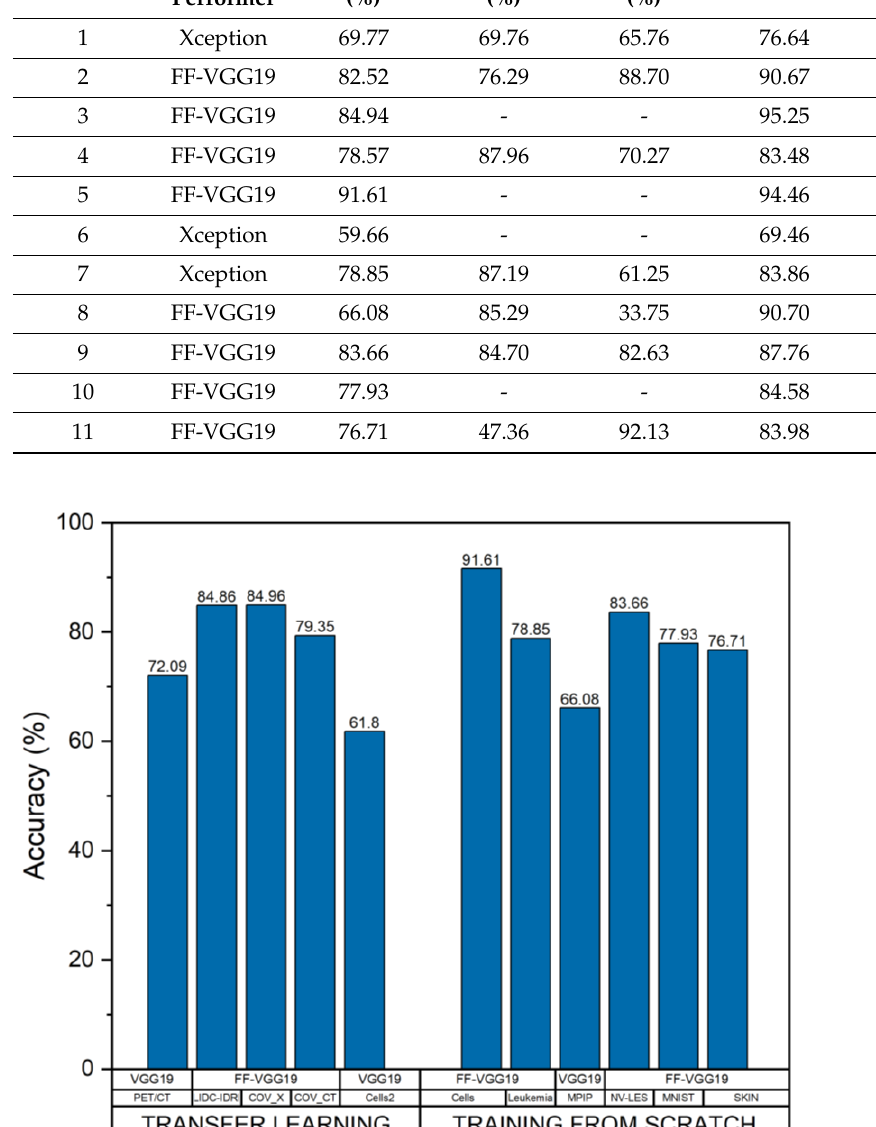
Figure 4. Best-performing CNNs and learning strategies for each of the experimental medical imaging